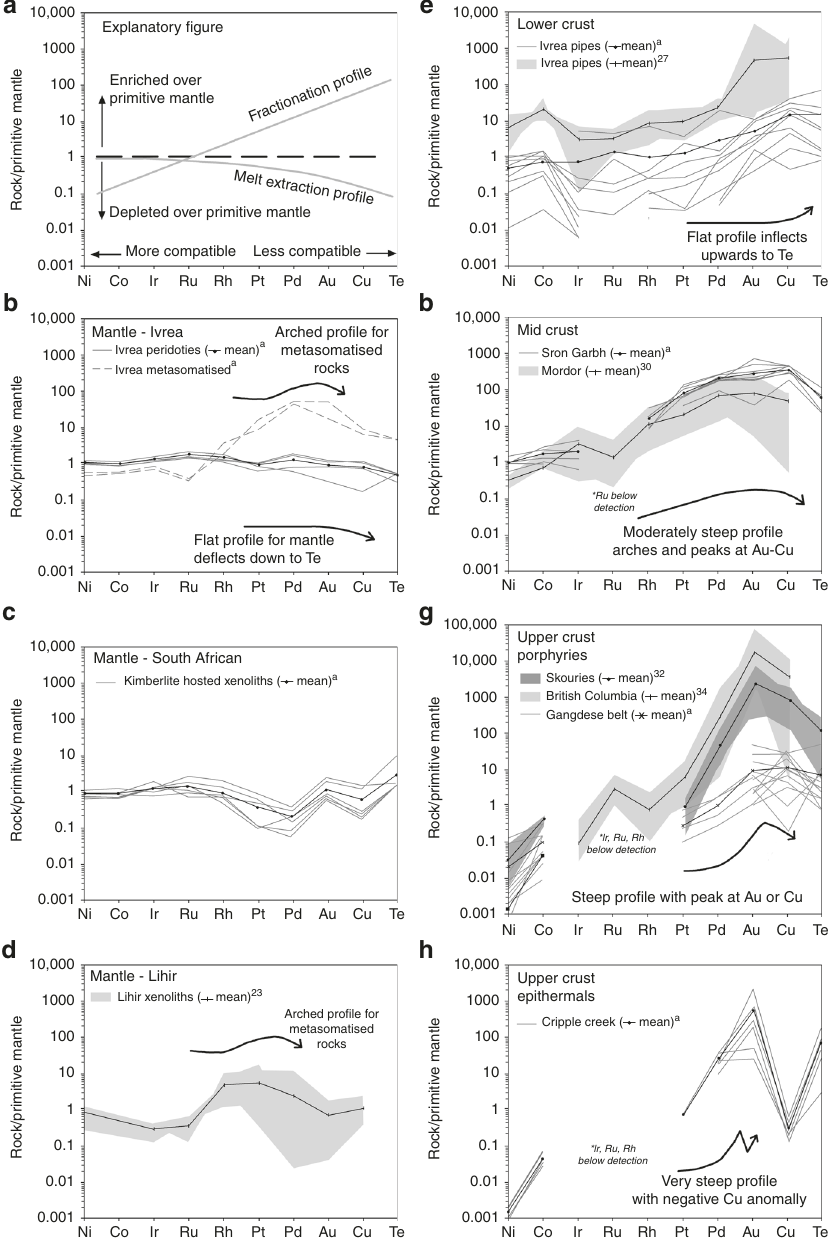
Fig. 1 Trans-lithospheric post-subduction chalcophile element pro fi les. Primitive mantle-normalised chalcophile element pro fi les as explained in ( a ) for: b - d mantle rocks from the Ivrea Zone ( b ), xenoliths from the Bultfontein kimberlite ( c ) and Lihir ( d ); e lower crustal intrusions; f mid-crust intrusions; g upper crustal magmatic – hydrothermal porphyry systems and h epithermal systems. Note: “ a ” indicates data from this study, whereas other data are cited in reference list. Normalisation values are from Palme and O ’ Neill 60